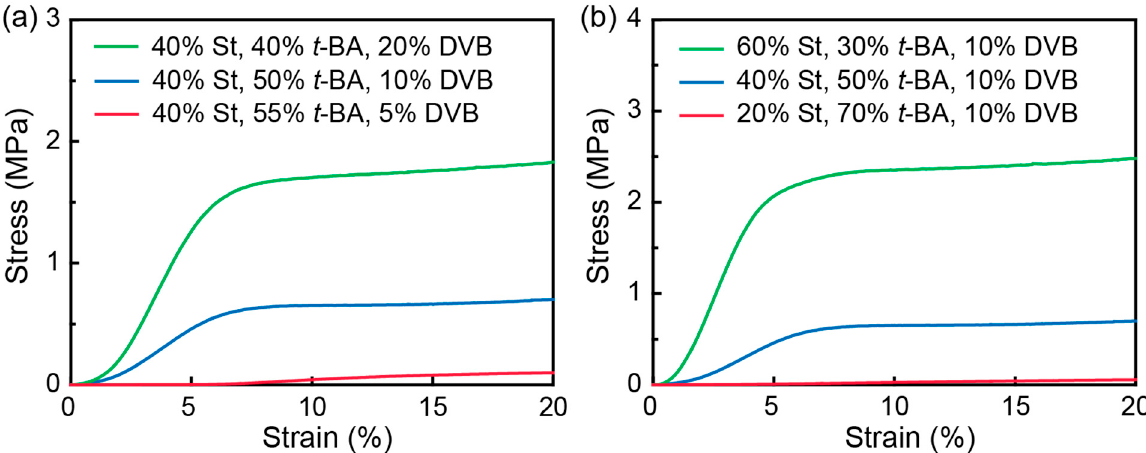
Figure 2. Tuning the mechanical properties of APEG-TPEs by adjusting the concentrations of styrene (St) monomers, t -butyl acrylate ( t -BA) monomers and divinyl benzene (DVB) cross-linkers. The compressive modulus ( a ) increases when the fraction of DVB increases or ( b ) when the fraction of t -BA decreases.